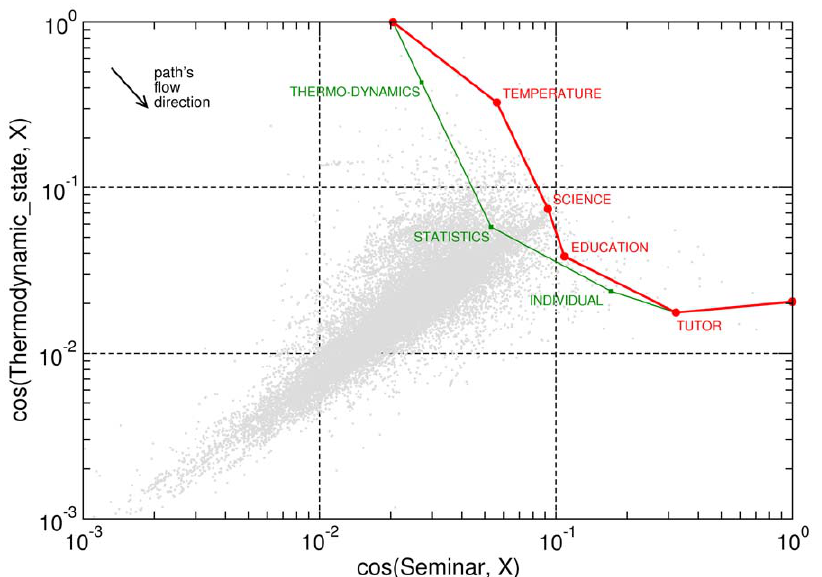
Figure 4. Similarity to target (Thermodynamic_State) vs. similarity to source (Seminar). Semantic navigation (red trajectory) behaves similarly to shortest path (green trajectory): there are only two degenerated shortest paths and one of them coincides with the semantic path. This example shows that semantic navigation efficiency can be optimal in some cases, because the number of jumps equals to that of shortest path navigation. Conversely, shortest paths sometimes can (accidentally) yield coherent paths in terms of meaning. The remaining similarity pairs with the rest of the network are depicted as a scatter plot.